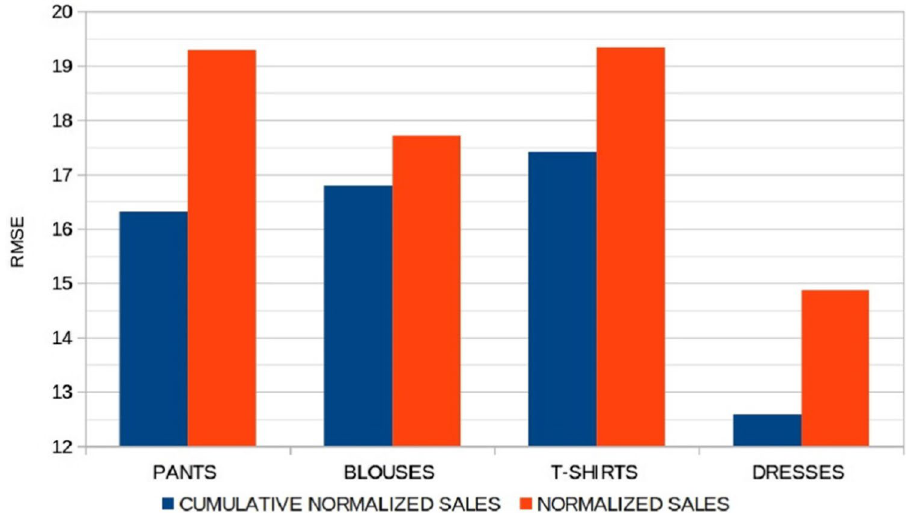
Fig. 10 Root mean squared errors when applying the pro- posed methodology to normal- ized and cumulative normalized sales